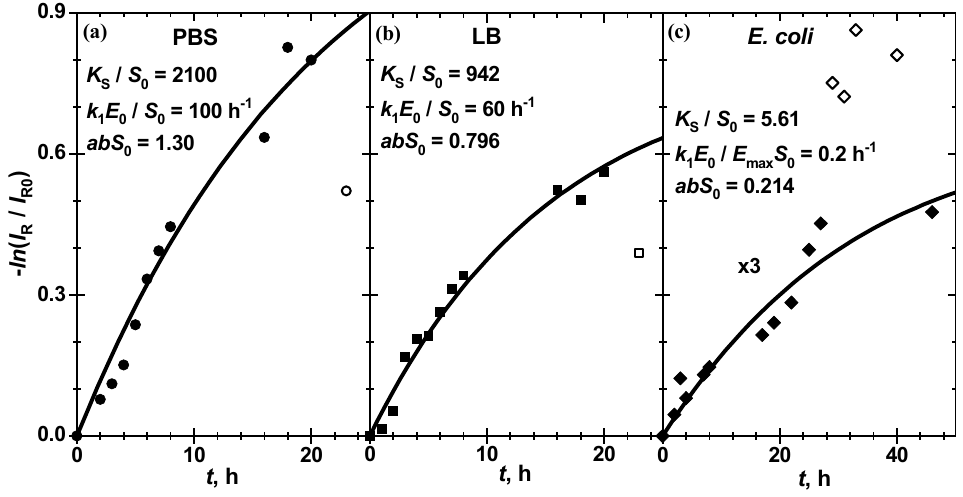
Figure 6. Evolution of the relative chromatic intensity − ln I R for the enzymatic cleavage of chitosan-g-X-Gluc by ß-Gus ( a ) in PBS at pH 7.4 (25 °C), ( b ) in LB at pH 7.0 (25 °C) as well as ( c ) in E. coli Mach1 bacterial suspension in LB at pH 7.0 (20 °C). The enzyme concentrations are 100 nM for ( a ) and 60 nM for ( b ). The stock bacterial suspension was diluted 5 times, corresponding to a bacteria concentration of 6 × 10 7 colony-forming units (CFU)/mL. ( c ). The fit function (5) to the filled circles data points is shown with the solid line. The thermodynamic and kinetic constants as well as the scaling factor abS 0 are shown in the panels. The outlier data points, which are not included in the analysis, are shown as open symbols.